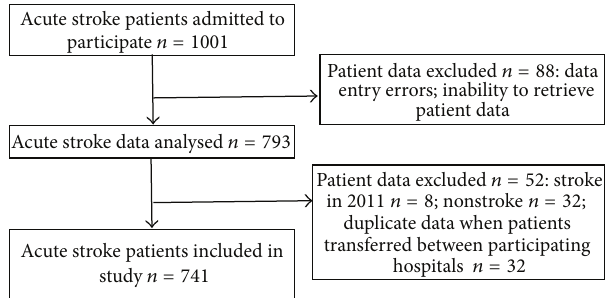
Figure 1: Study flow